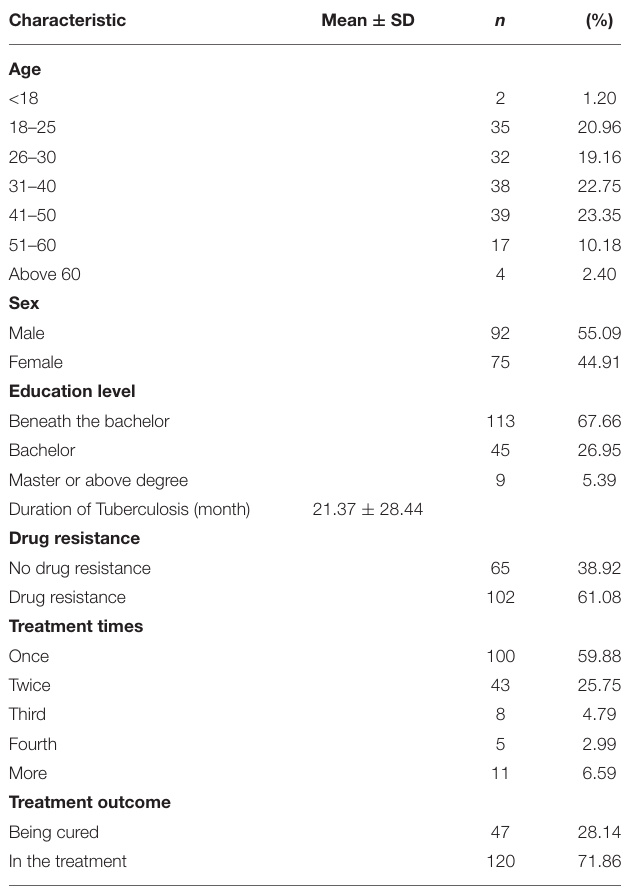
TABLE 1 | Characteristics of TB